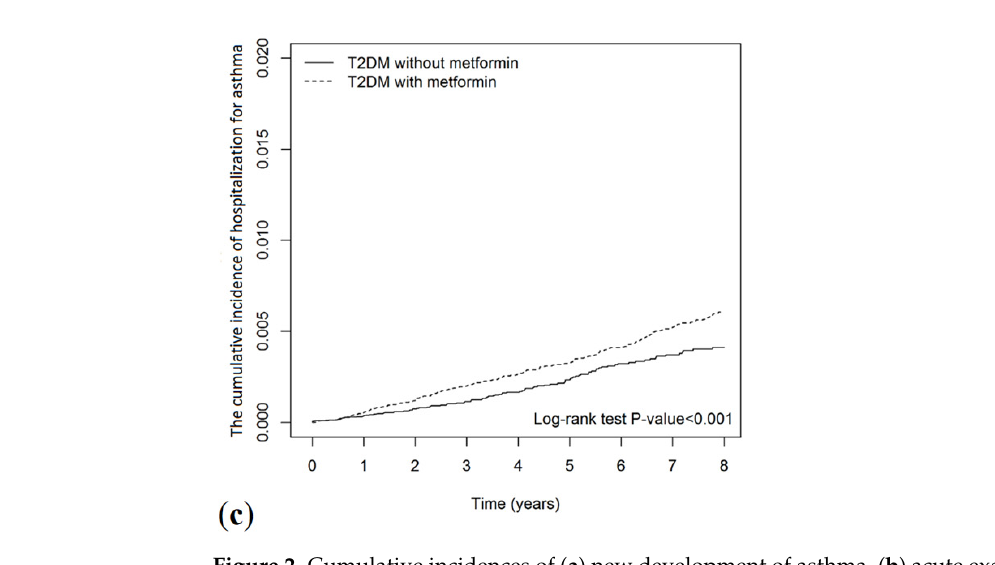
Figure 2. Cumulative incidences of ( a ) new development of asthma, ( b ) acute exacerbation of asthma, and ( c ) hospitalization for asthma for metformin users vs. nonusers. Table 3. Hazard ratios (HRs), and 95% confidence intervals (CIs) for outcome disease among the sampled patients.